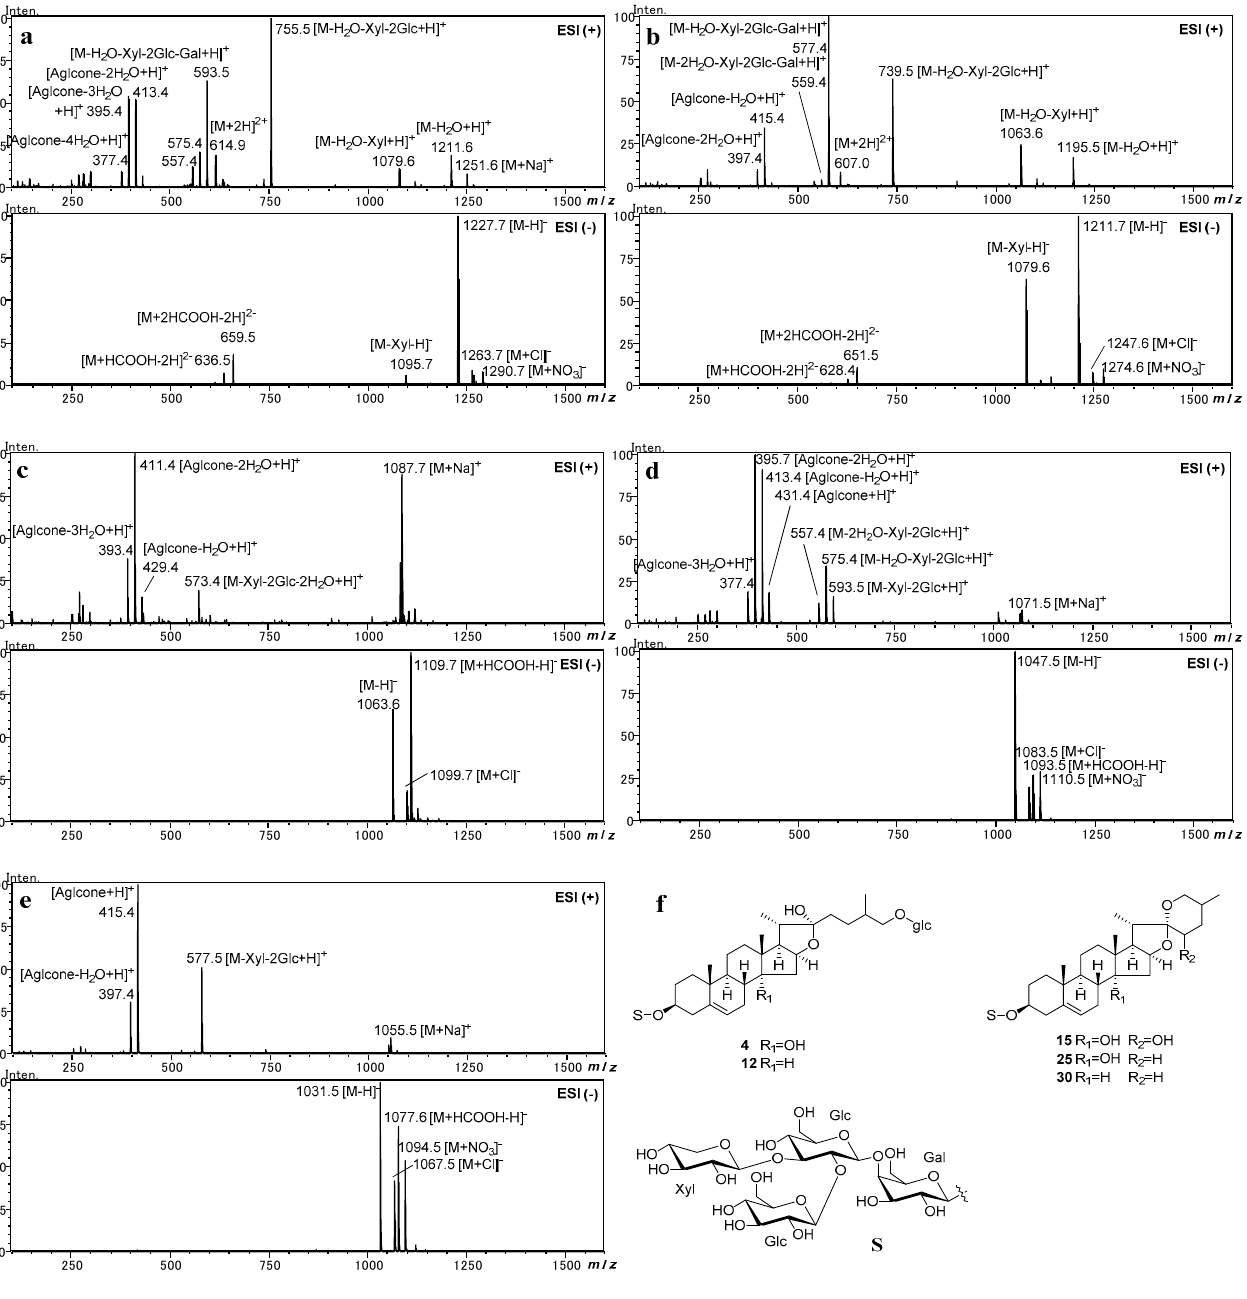
Figure 1. ESI-MS spectra and structure of authentic steroidal glycosides: ( a ) ESI-MS spectra of polygonatumoside F ( 4 ); ( b ) ESI-MS spectra of timosaponin H1 ( 12 ); ( c ) ESI-MS spectra of sibiricoside B ( 15 ); ( d ) ESI-MS spectra of (25 R )-(3 β ,14 α )-dihydroxy-spirost-5-ene-3-O- β -D-glucopyranosyl-(1 → 2)-[ β -D-xylopyranosyl-(1 → 3)]- β -D-glucopyranosyl-(1 → 4)- β - D -galacopyranoside ( 25 ); ( e ) ESI-MS spectra of 25 S -aspidistrin ( 30 ); ( f ) Structure of authentic steroidal glycosides. Polygonatumoside F ( 4 ) and timosaponin H1 ( 12 ) were selected for investigating the mass fragmentation pathway of furostane-type steroidal glycosides. The chemical struc- tures of 4 and 12 were different from each other only in the 14-hydroxy moiety. In the negative ion mode, both 4 and 12 provided deprotonated molecule ions [M-H] - as the dominant ion peak. They also provided the fragment ions [M-Xyl-H] - at m/z 1095 for 4 and m/z 1079 for 12 , respectively. It is noteworthy that divalent ions peaks [M+2HCOOH-2H] 2- and [M+HCOOH-2H] 2- were observed at m/z 659 and 636 for 4 , at m/z 651 and 628 for 12